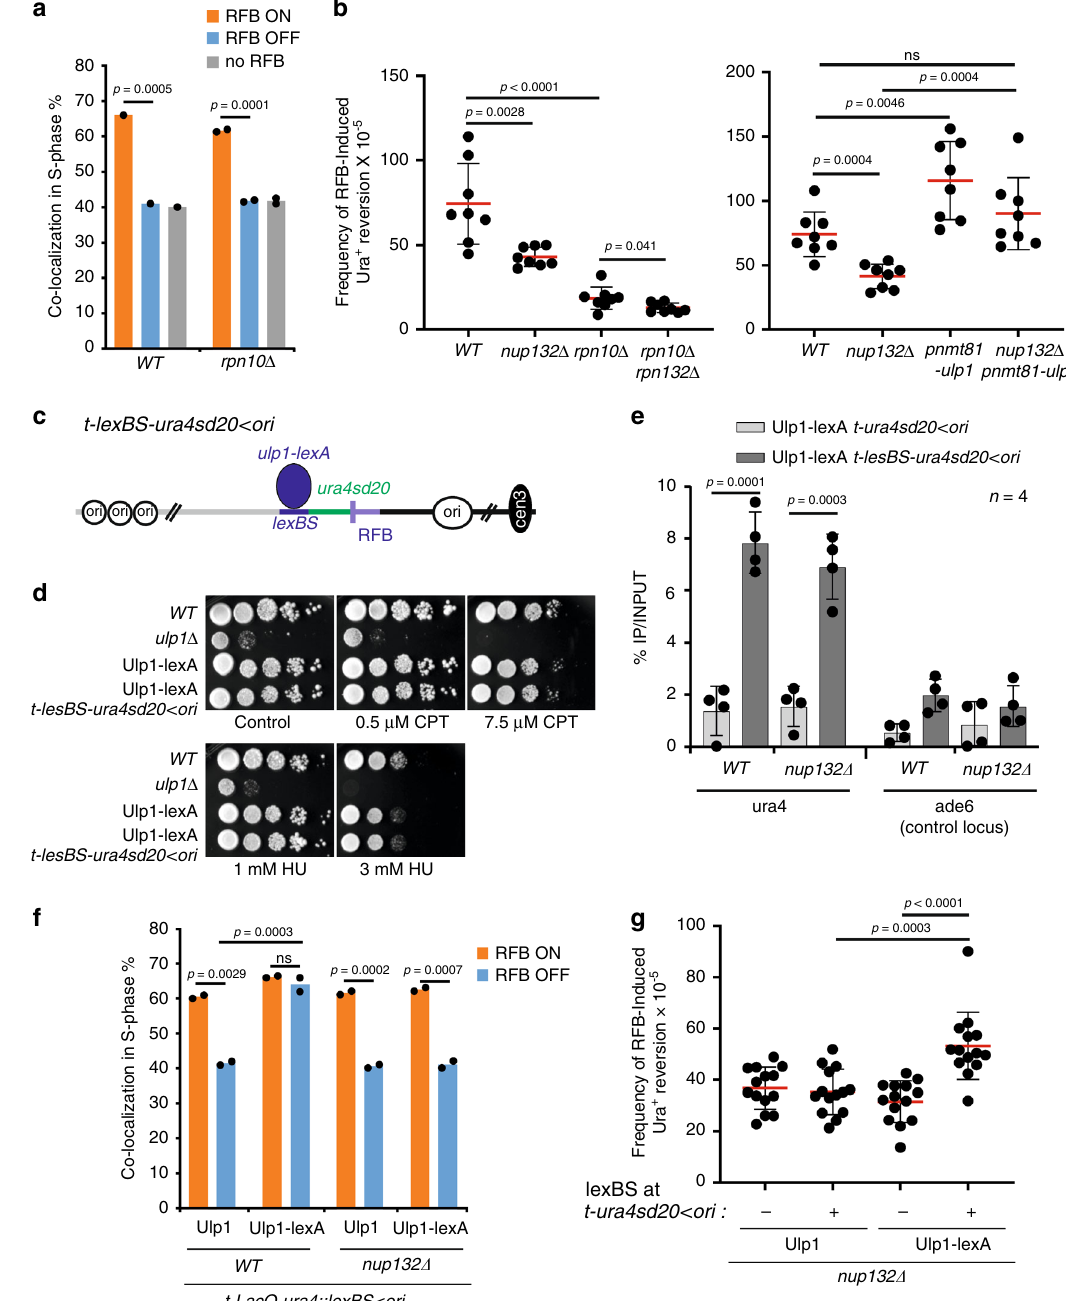
Fig. 6 Proteasome and Ulp1 activity are necessary to clear off SUMO conjugates to promote RDR. a Co-localization event in S-phase cells in indicated conditions and strains as on Fig. 2a. p value was calculated by Fisher ’ s exact test for OFF and ON groups for each mutant and condition. b Frequency of RFB-induced Ura + reversion in indicated strains and conditions. Each dot represents one sample from eight independent biological replicate for each strain. Bars indicate mean values ± SD. p value was calculated by two-sided t -test. c Diagram of construct containing lexA-binding site (lexBS, purple) that allows tethering of Ulp1-lexA to the t-lexBS-ura4sd20 < ori construct ( d , e , g ) or to the t-Laco-ura4::lexBS < ori construct ( f ). d Sensitivity of indicated strains to indicated genotoxic drugs. Ten-fold serial dilution of exponential cultures were dropped on appropriate plates. e Binding of Ulp1-LexA to ura4 or ade6 (unrelated control locus) in the presence of LexBS ( t-lexBS-ura4sd20 < ori ) or not ( t-ura4sd20 < ori ). Values are mean of four independent biological repeats ± SD. p value was calculated using two-sided t- test. f Co-localization event in S-phase cells in indicated conditions and strains as on Fig. 2a. p value was calculated by Fisher ’ s exact test for OFF and ON groups for each mutant and condition. g Frequency of RFB-induced Ura + reversion in indicated strains and conditions. Each dot represents one sample from 14 independent biological replicate for each strain. Bars indicate mean values ± SD. p value was calculated by two-sided t